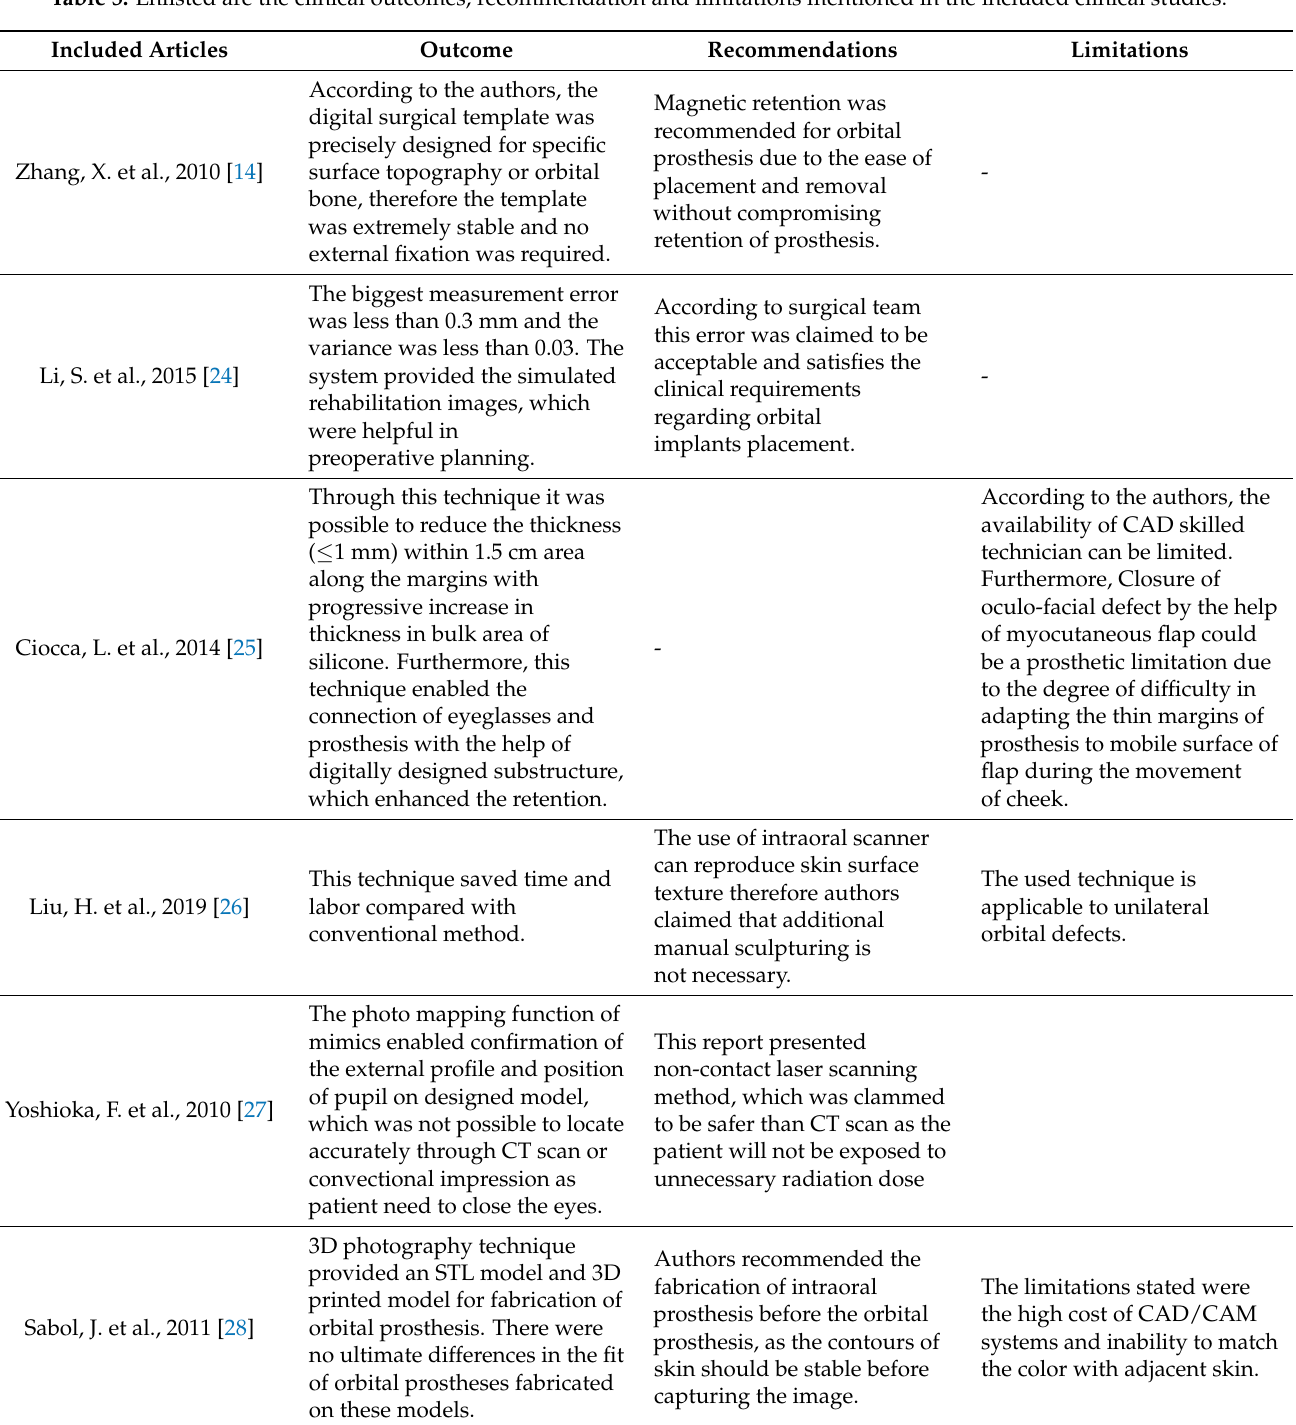
Table 5. Enlisted are the clinical outcomes, recommendation and limitations mentioned in the included clinical